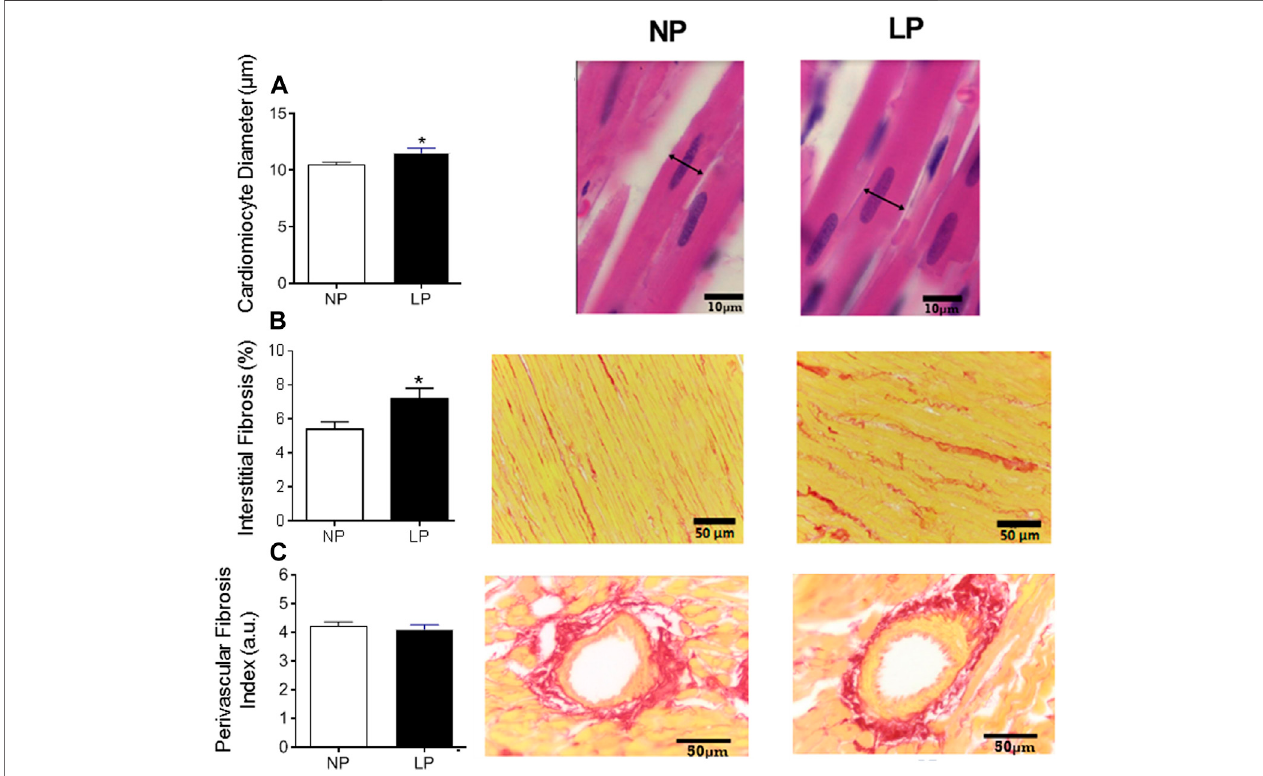
FIGURE 5 | Histological analysis of the heart. Mean value of cardiomyocytes in cross section (scale bar = 10 μ m) and representative pictures from each group (A) , cardiacinterstitial fi brosis(scalebar=50 μ m)andrepresentativepicturesfromeachgroup (B) andperivascular fi brosisindexintheleftventricularvasculature(scalebar= 50 μ m)andrepresentativepicturesfromeachgroup (C) , n =5 – 10animalspergroup.NP,normalproteindiet;LP,lowproteindiet.Valuespresentedasmean±SD*** p < 0.001, ** p < 0.01, and * p < 0.05 indicate statistical signi fi cance (Student ’ s T